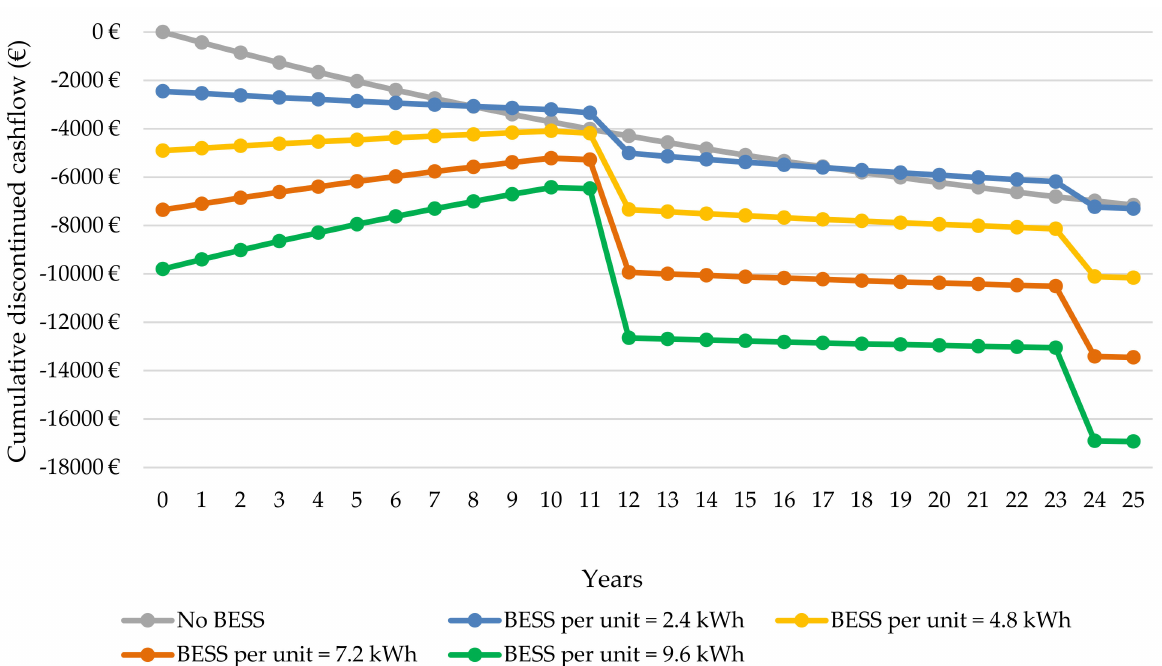
Figure 14. Comparison of cumulative discounted cash flows relating to the BESSs system for the first scenario with different BESS capacities installed during the PV system’s expected